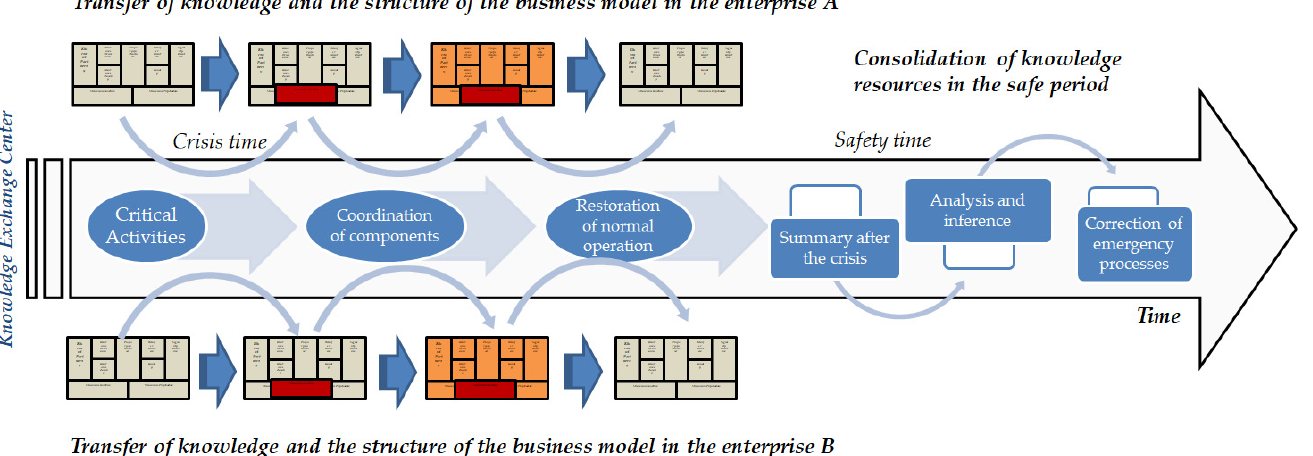
Figure 3. Transformation of the business model and the process of feedback in the exchange of knowledge with the knowledge exchange center. Source: own study.